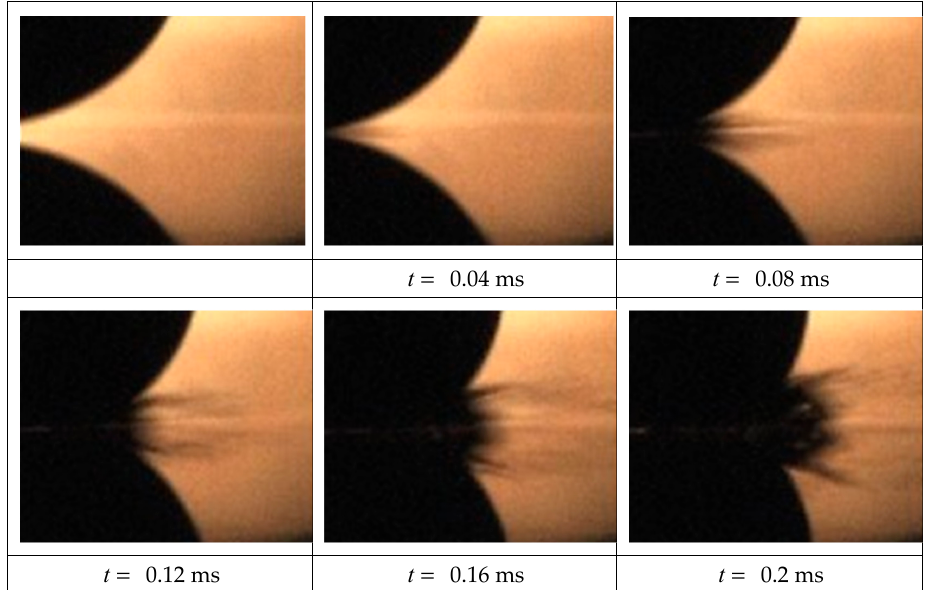
Figure 16. A fine structure of near-surface flows in intrusive mode of droplet coalescence ( D = 4.3 mm, U = 1.0 m/s, ink solution diluted in ratio 1:200, shooting rate 25,000 fps, sight line directed at α = 2 ◦ to the